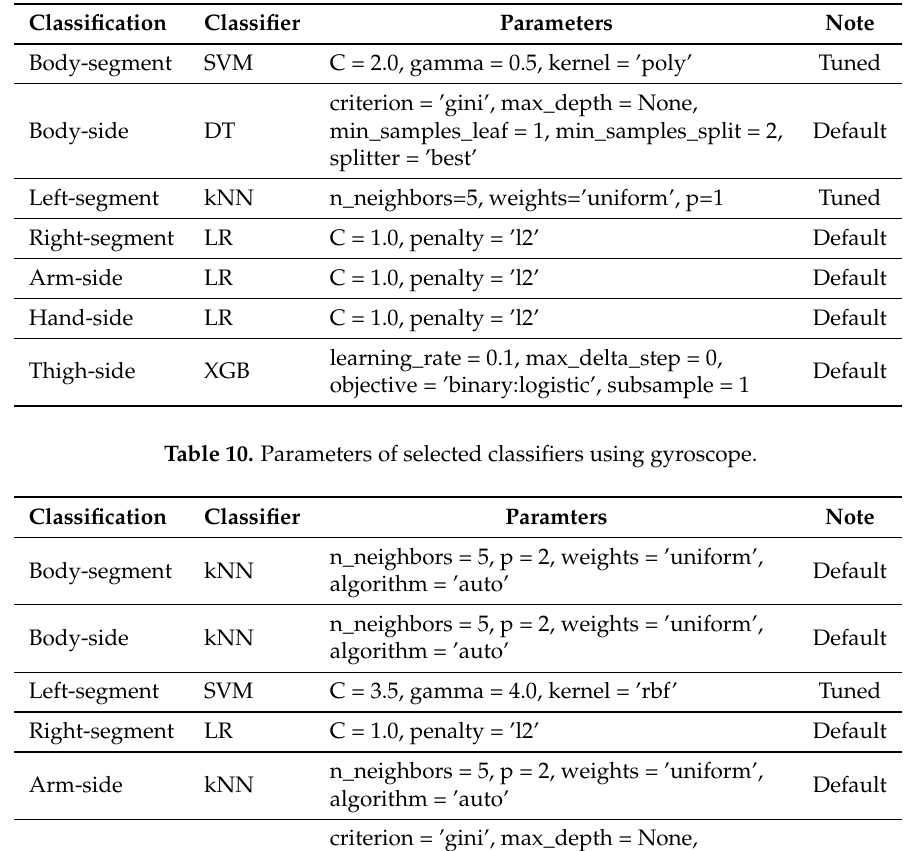
Table 9. Parameters of selected classifiers using the accelerometer.